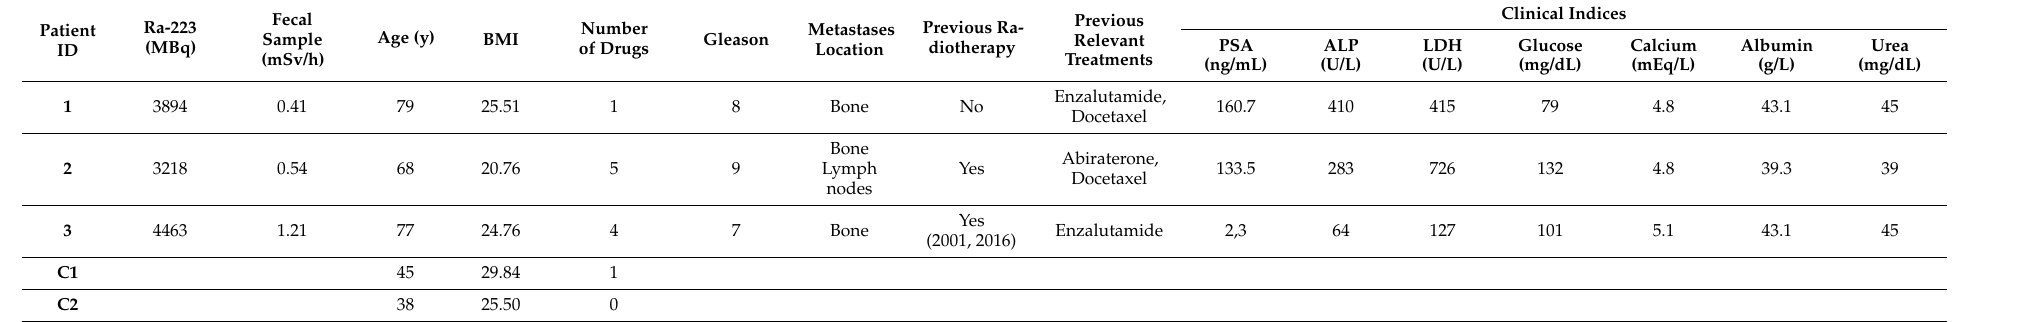
Table 2. Patients and healthy volunteers’